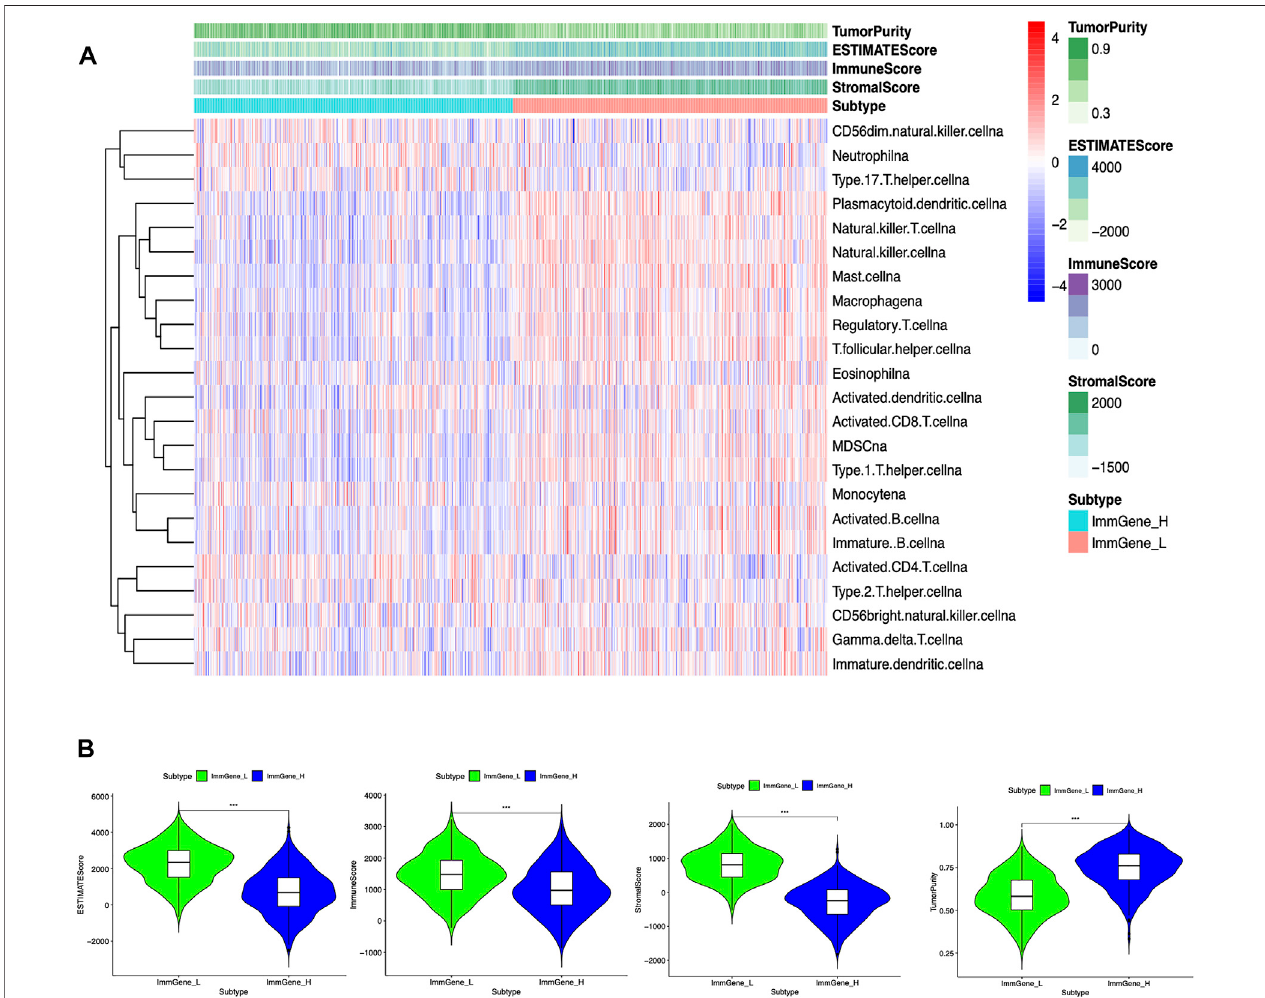
FIGURE 7 | Associations of the tumor microenvironment with m6A regulatory genes (A) Heat map. The ordinate signi fi es the immune gene set and the abscissa represents the sample name (B) Violin plot. *** p < 0.001; ** p < 0.01; * p < 0.05.